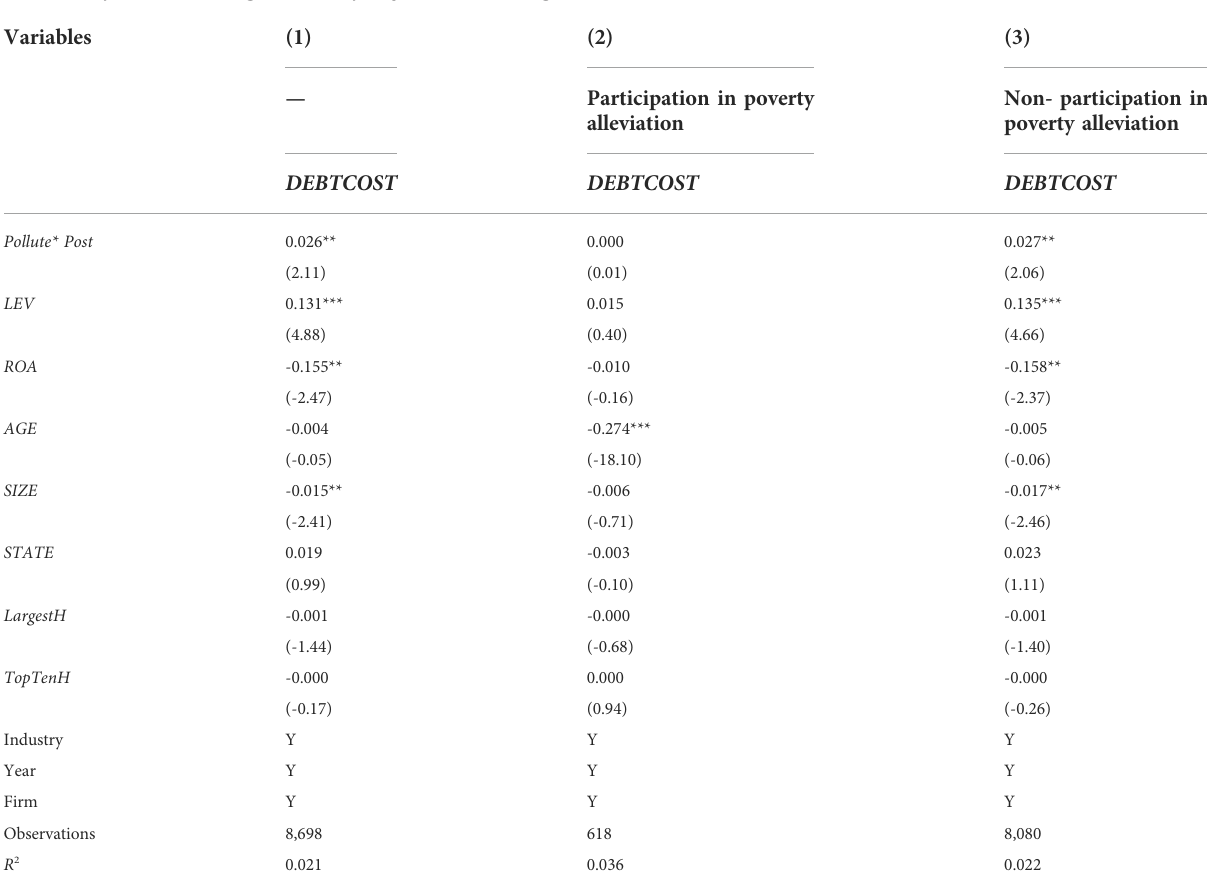
TABLE 5 Empirical results on green credit policy and the fi nancing cost.